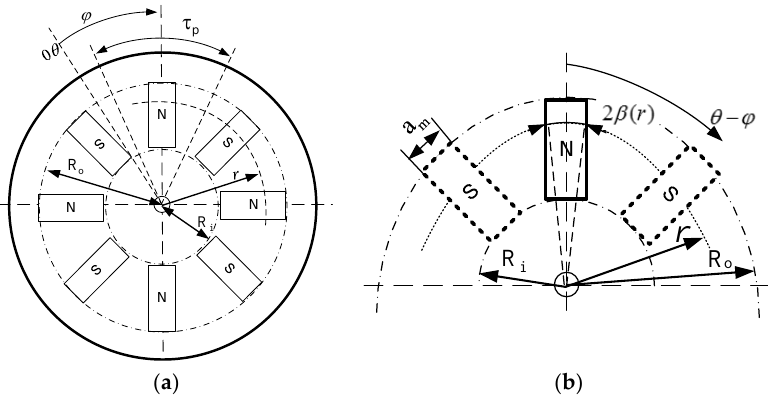
Figure 4. ( a , b ) Arrangement of permanent magnets with an exemplary shape.